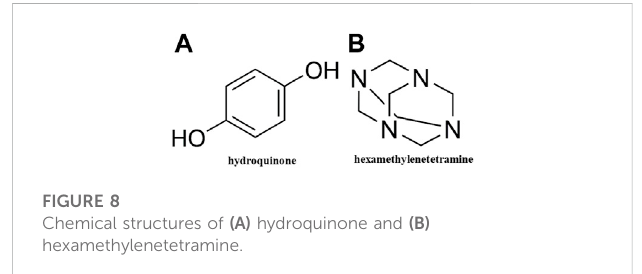
FIGURE 8 Chemical structures of (A) hydroquinone and (B) hexamethylenetetramine.